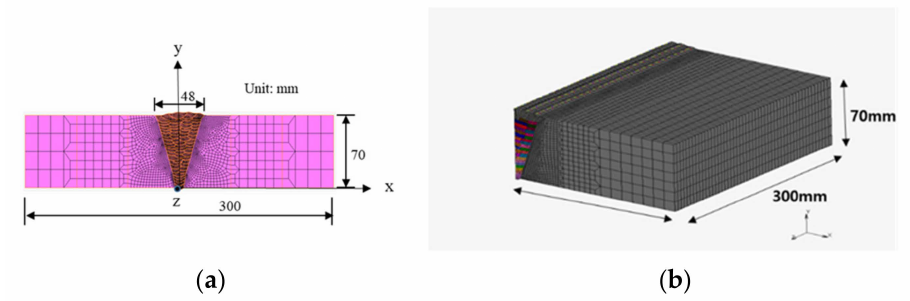
Figure 2. Analysis model: ( a ) a 2D model and ( b ) a 3D